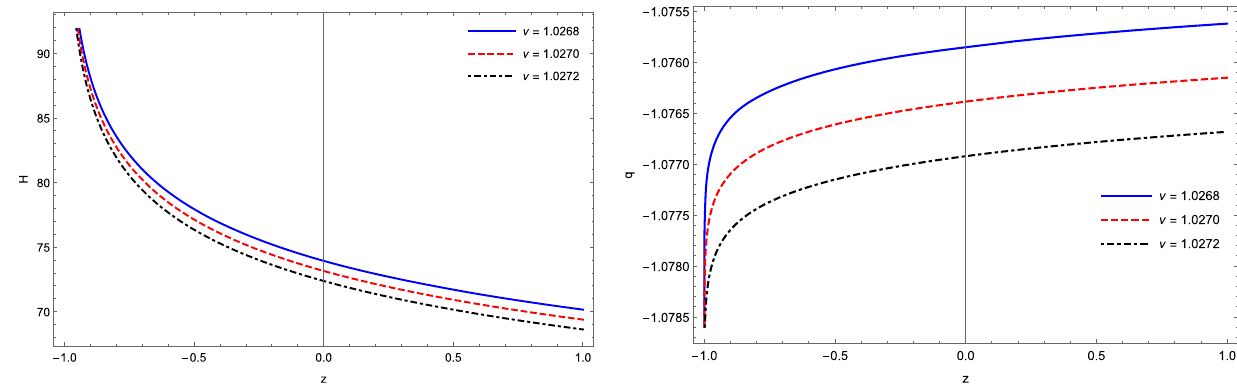
Fig. 1 Hubble parameter (left panel) and deceleration parameter (right panel) in redshift. The parameter scheme: α = 0 . 21